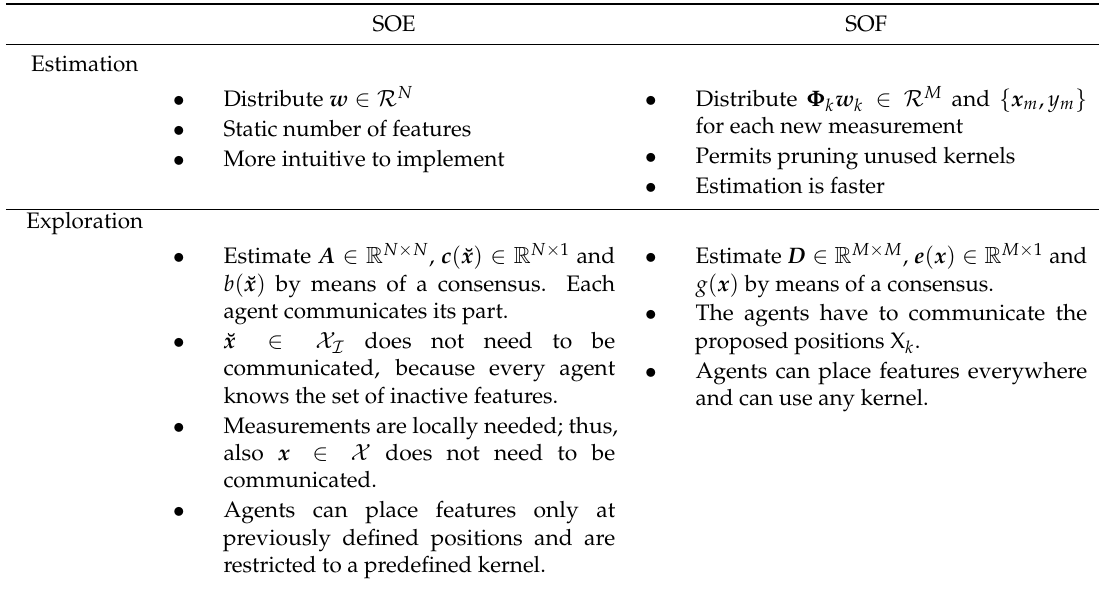
Table 1. Differences between the distribution